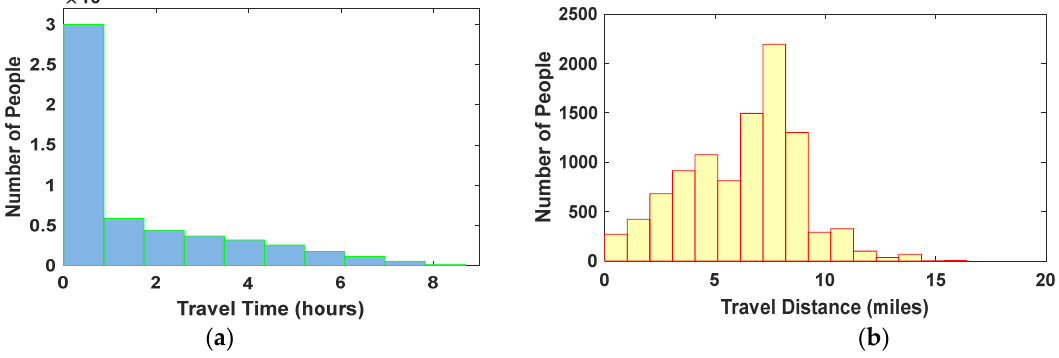
Figure 9. ( a ) Number of people vs. travel time intervals (hours) ( b ) Number of people grouped based on the travel distance to an EEI.